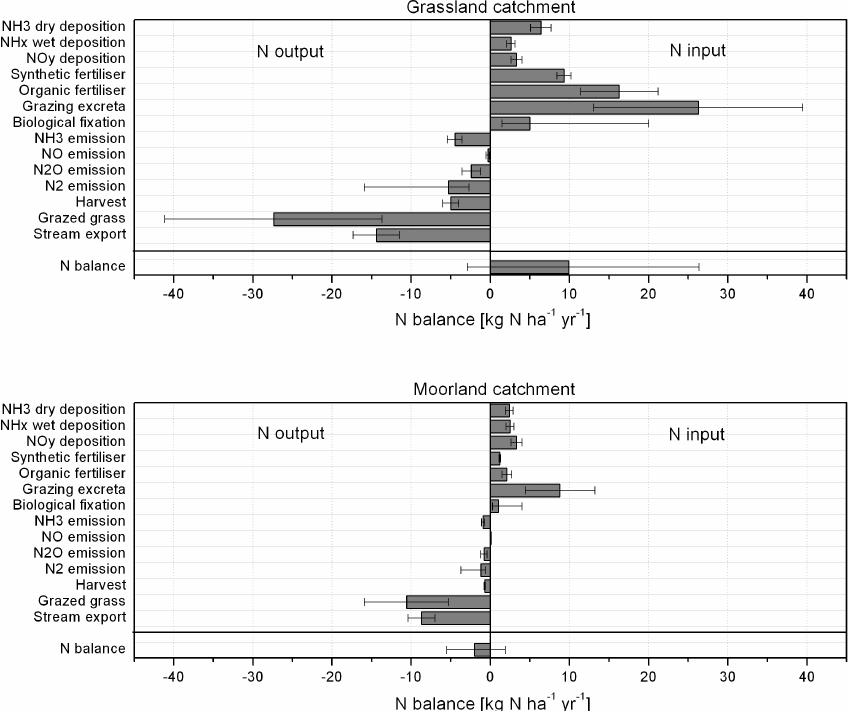
Fig. 8. Catchment soil N budgets for the Grassland catchment (top) and the Moorland catchment (bottom). Inputs and outputs are shown as positive and negative N exchanges (kgNha − 1 yr − 1 ) with the overall N balance shown at the bottom. Error bars represent the estimated uncertainty for the individual budget terms (see subsections under Sects. 2.3 and 2.4) with the N balance error calculated accordingly (see Sect.